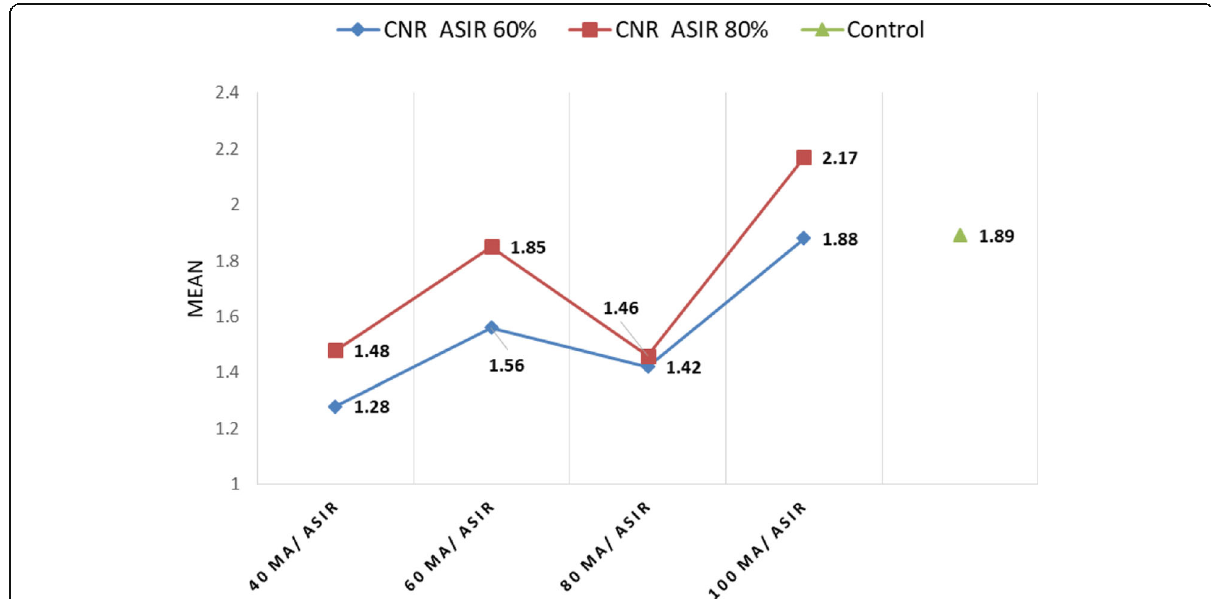
Fig. 4 The mean values of measured CNR in the CT images with the different used reduced mAs, with 60% ASIR-V (blue) and 80% ASIR-V reconstruction (red) of the ASIR group and non-ASIR standard dose (control) group CT images (green)